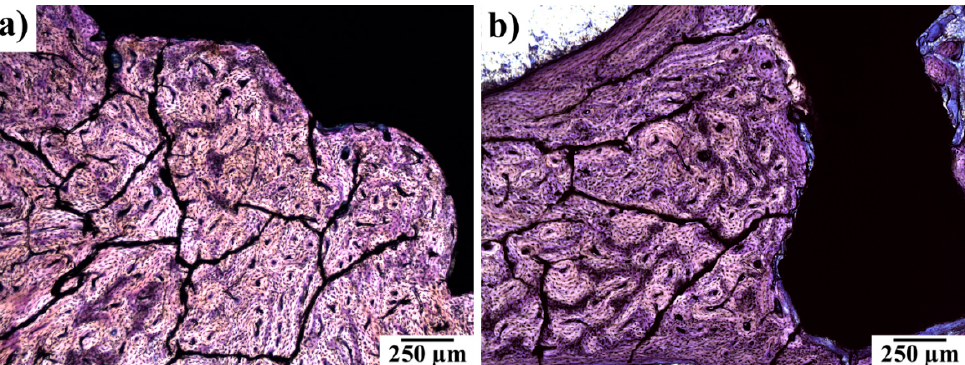
Figure 4. SEM-EDS observation of the bone section with the implanted screw. ( a ) SEM picture of the overview; ( b ) SEM picture of the screw–bone interface; ( c ) SEM picture of the area mapped via EDS (the elemental maps are shown below); and ( d ) a detailed view (SEM) of the layer of corrosion products.